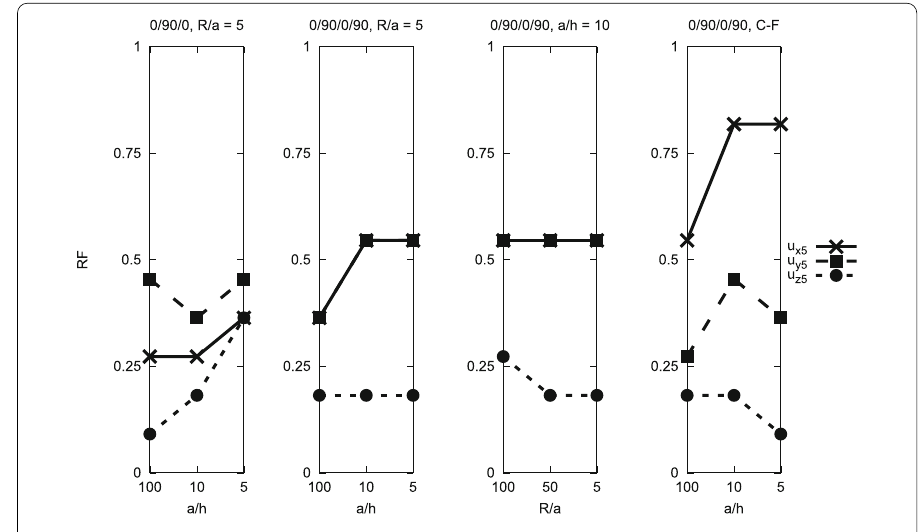
Fig. 15 RF for fourth-order displacement